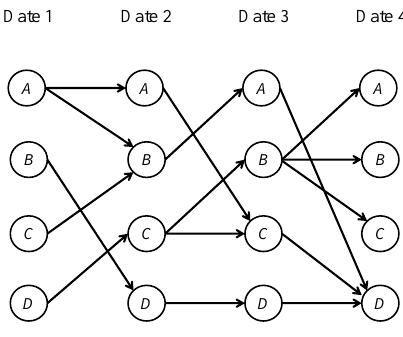
Figure 2. MLCS: example of possible